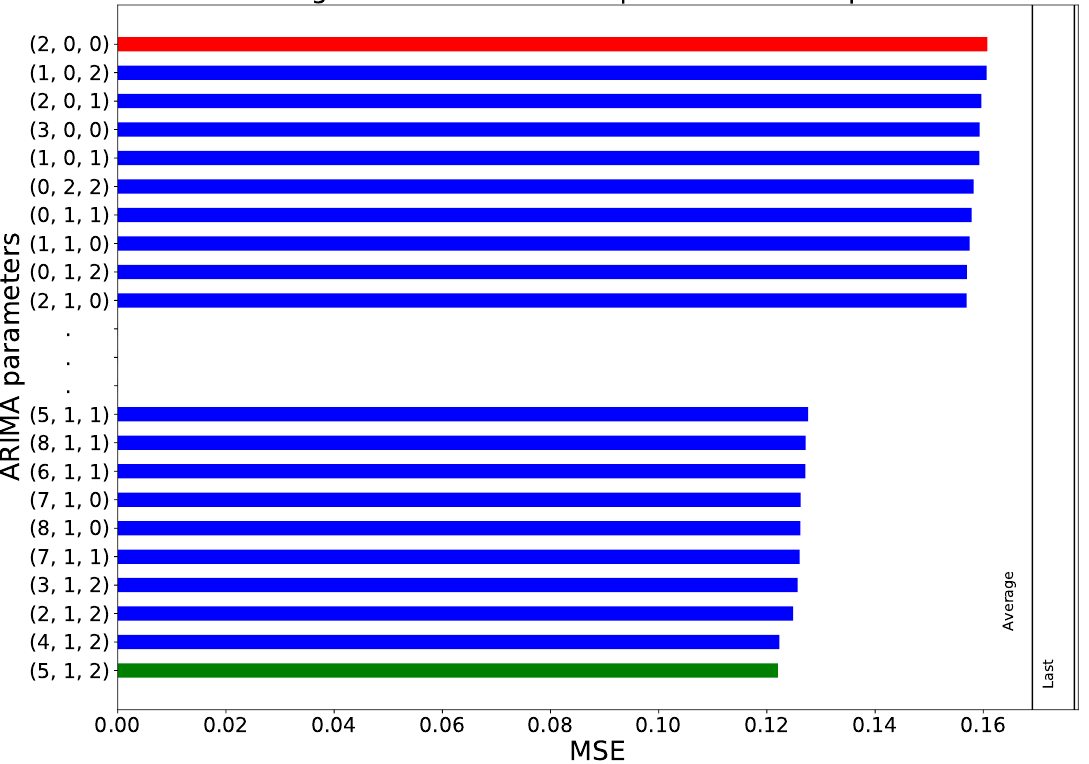
Figure 3. Comparison between different parametrisations of the ARIMA model, in terms of the MSE of the forecast, when applied to the refrigerator’s data set. The red and green bars respectively indicate the worst and best set of parameters. Additionally, the two vertical lines represent the values yielded by the two validation methods, i.e., the last and average